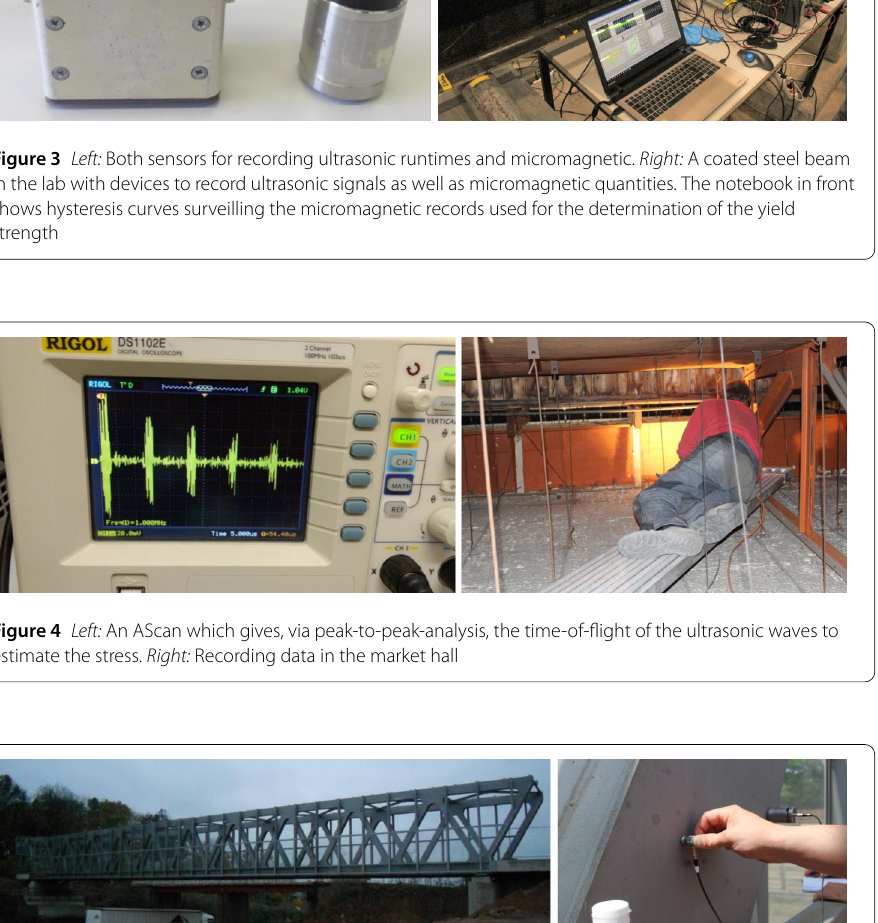
(compare Fig. 6 for a complex statical example) which makes an application of the Gaus- sian algorithm (or something equivalent) insufficient on the other hand. To fit a regression model to the data, we need to develop a stochastic model of the ultrasonic measurements. The time-of-flight of the ultrasonic wave in every point measured should be related to the local stress in the beam. Additionally, the residuals have to be taken into account for (stochastic) dependency modeling. Finally, a segmented regression approach based on the statical system and statistical decision criteria, was developed, for details see [9, 11] as a prequel to the estimation of the internal forces, with algorithms implemented in MAT- LAB and R, cf. [12, 13]. Unless the times-of-flight are observed in practice we work with simulated stresses according to equation (1) in the sequel to simplify